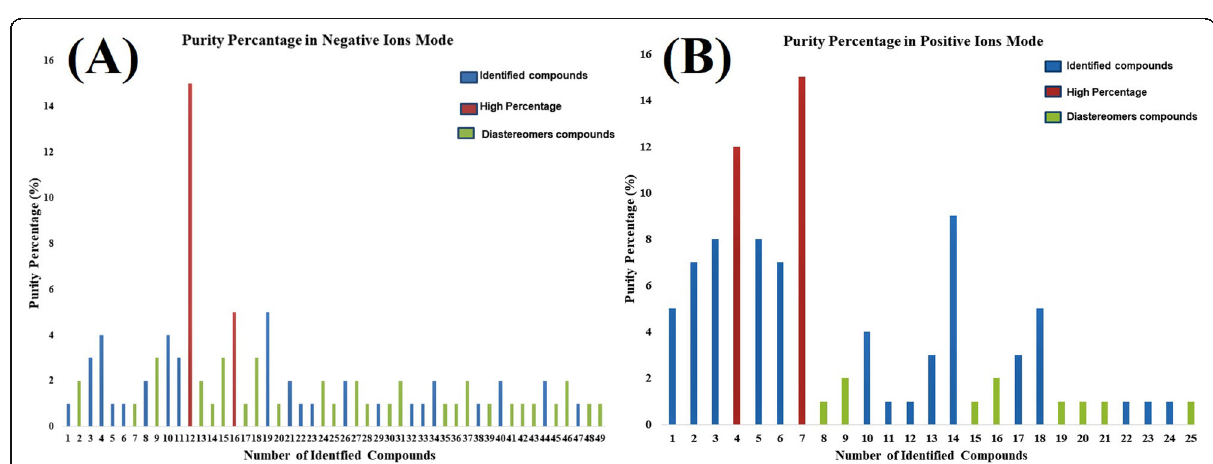
Fig. 8 A Purity percentage of identified compounds present in negative ion mode in active plant extract. B Purity percentage of identified compounds present in positive ion mode in active plant